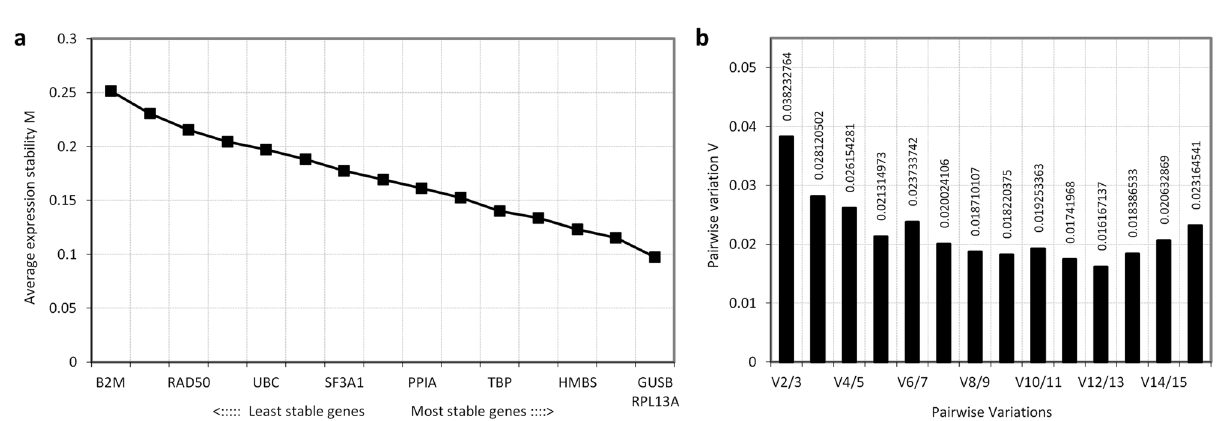
Figure 2. geNorm candidate RG output. Results of ( a ) the average stepwise exclusion analysis to determine genes with highest stability expressed as average expression stability (M) values, and ( b ) pairwise variation (V) values, to determine the optimal number of RGs. Consensus for M and V value cut-off is 0.5 and 0.15, respectively. Sixteen candidate RGs were assessed across n = 7 cell lines (reverse transcribed in triplicate and combined, and subsequently assayed in technical triplicates). Calculated relative quantity (RQ) of mean Ct values were used as input. Data represent one independent